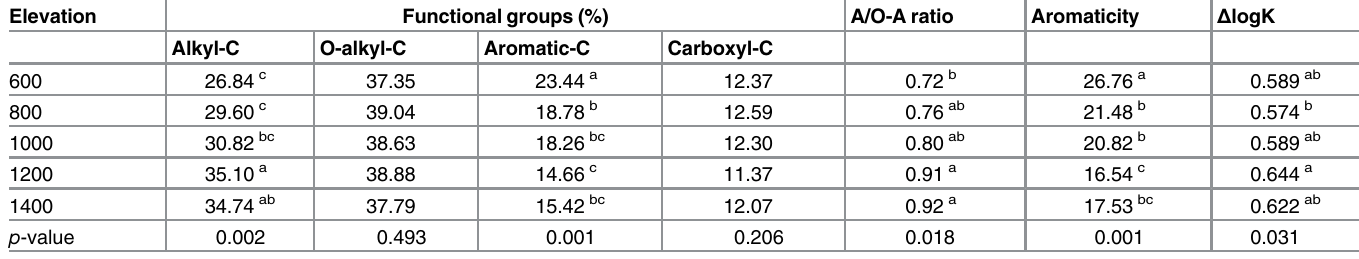
Values within a column followed by different letters are signi fi cantly different at p = 0.05.